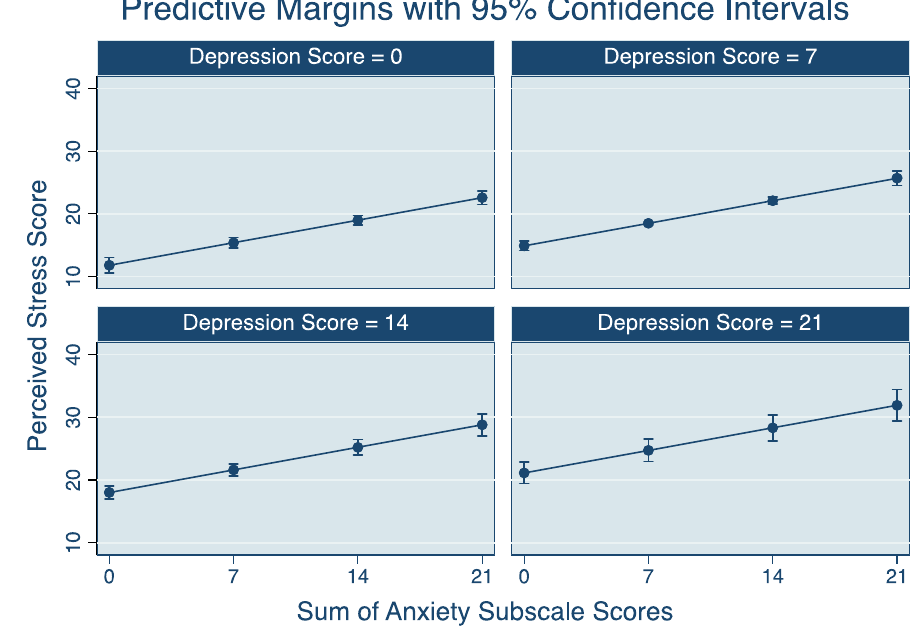
Figure 1. Predicted effects of the Hospital Anxiety and Depression Scale (HADS) anxiety score on Perceived Stress Scale Scheme 1. Note: Depression scores, according to the Hospital Anxiety and Depression Scale cutoffs, are as follows: 0 = no caseness, 7 = mild caseness, 14 = moderate caseness, and 21 = severe caseness.